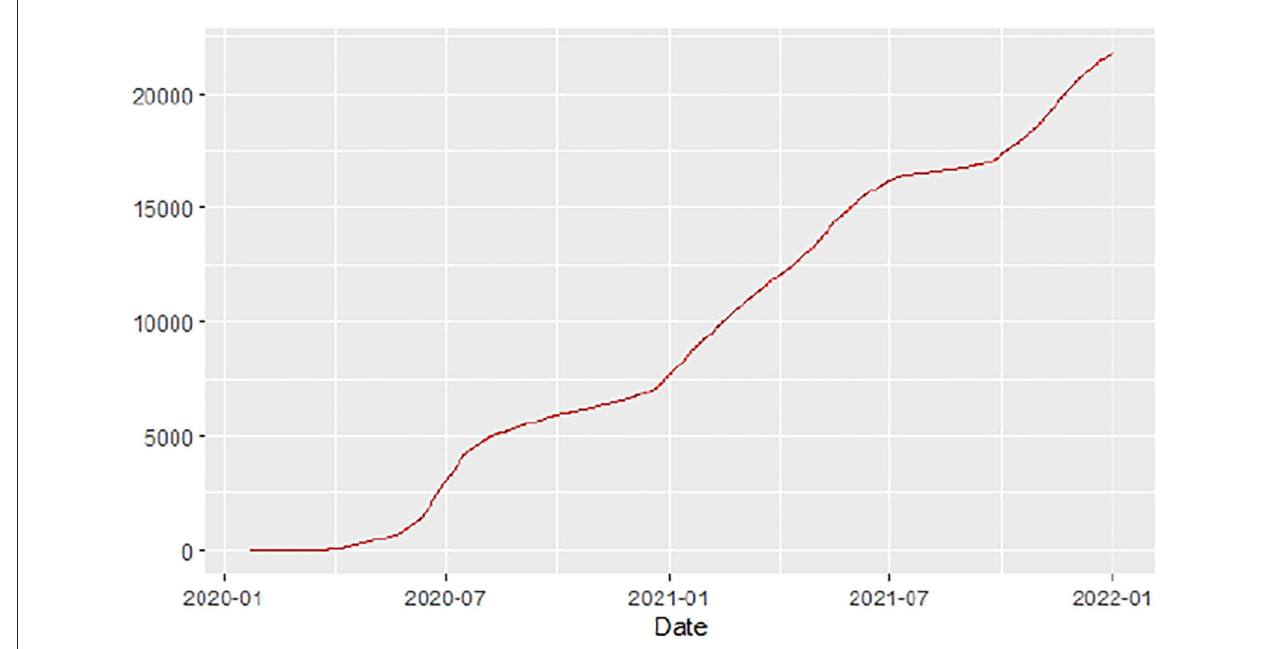
FIGURE 13 | Egypt deaths.